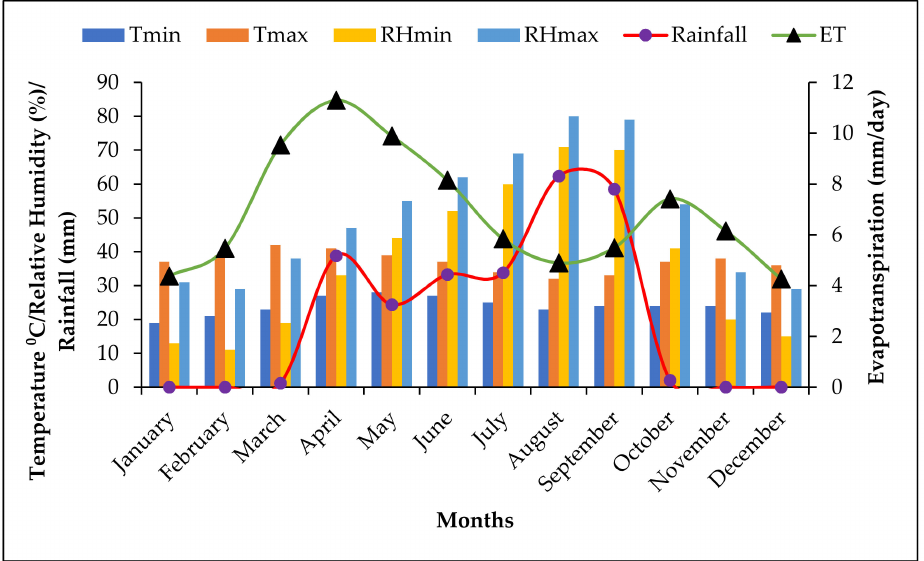
Figure 7. Variation in meteorological variables of temperature, precipitation, and evapotranspiration for the year, 2017, extracted from https: // www.worldweatheronline.com / .